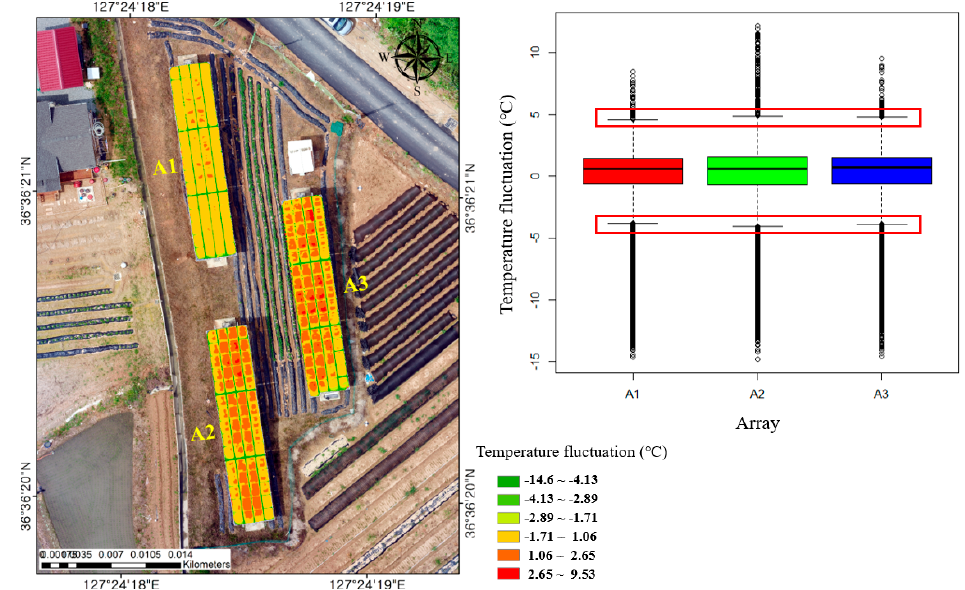
Figure 8. Distribution map of the temperature fluctuation component of each photovoltaic (PV) array and the boxplot.